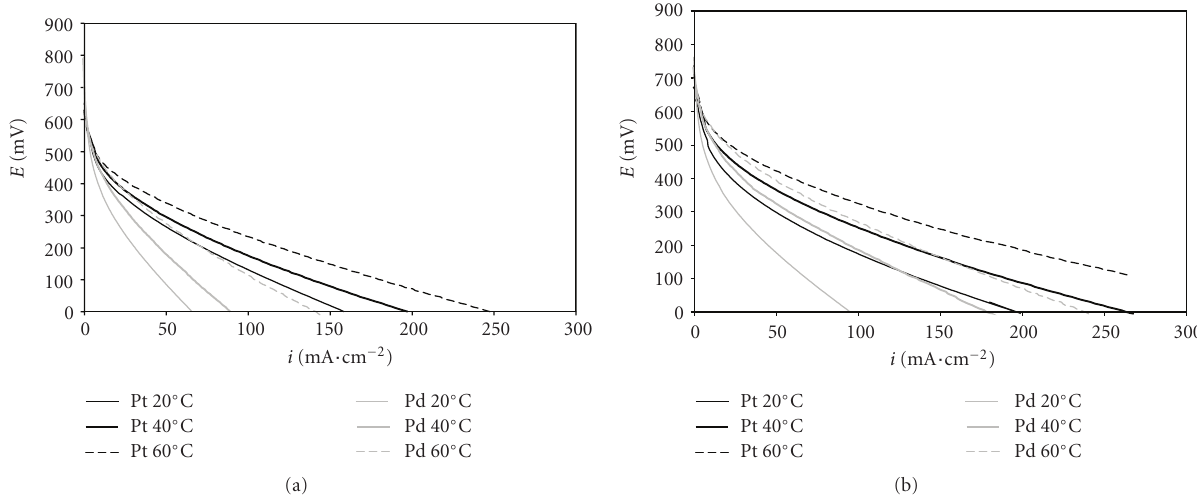
Figure 4: (a) Comparison of polarization curves of a direct methanol fuel cell operating with air and 3M methanol with Pd/C and commercial Pt/C from E-tek as cathode catalyst at 20, 40, and 60 ◦ C. (b) Comparison of polarization curves of a direct methanol fuel cell operating on oxygen and 3M methanol with Pd/C and commercial Pt/C from E-tek as cathode catalyst at 20, 40, and 60 ◦ C.